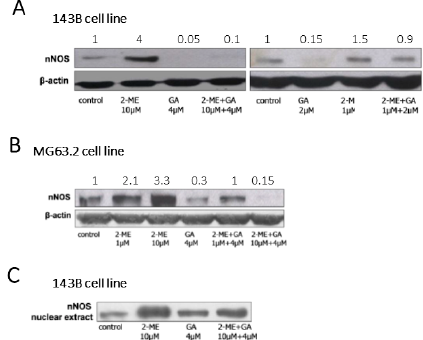
Figure 3. GA abrogates stimulatory effect of 2-ME on nNOS expression and nuclear translocation in 143B and MG63.2 cell lines. Total pool of nNOS in OS 143B ( A ), MG63.2 ( B ) cells and in nuclear extract of 143B cells ( C ) treated with either 2-ME or GA, or a combination of both compounds. 143B and MG63.2 OS cells were treated with vehiculum (Control), 2-ME (1 μ M, 10 μ M) or GA (2 μ M, 4 μ M) or combination of both for 8 h. The cells were then harvested and total level of nNOS was established by western blotting. The cytoplasmic and nuclear fractions were separated using the Nuclear Extract Kit (Active Motif, France) according to manufacturer’s protocol. The representative data from three experiments are presented.